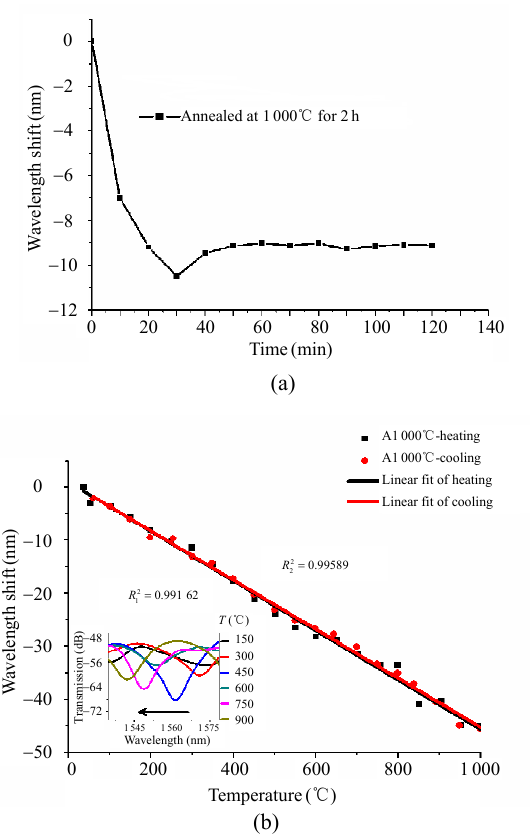
Fig. 11 Process of annealing at 1000 for 2 ℃ h: (a) time evolution of the wavelength shift and (b) wavelength shift versus temperature for the sensor after the annealing process.